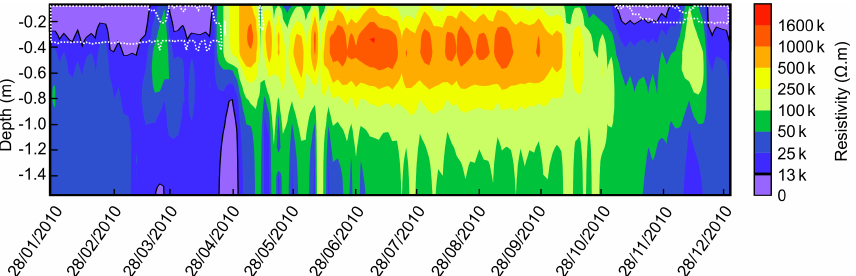
Figure 11. Evaluation of the temporal resistivity variability in virtual borehole S 3 , 3 inferred from inverted A-ERT data for the period January 2010 to December 2010. The black line delineates the cut-off value of 13k (cid:127) m, and the white dashed line shows the 0 ◦ C isotherm from the borehole temperatures at S 3 , 3